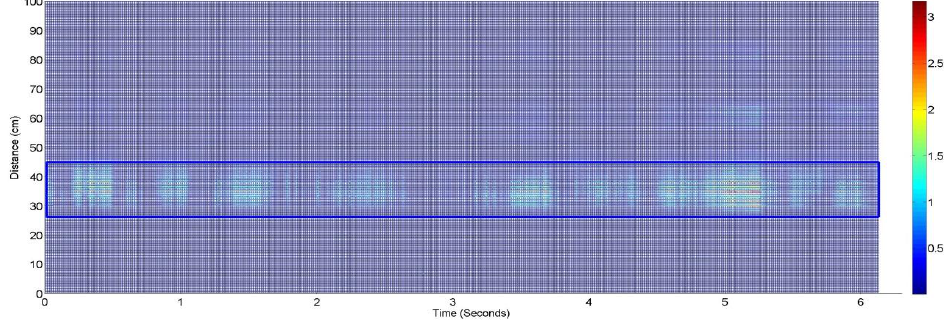
Figure 3. Waveforms after clutter removal where the part highlighted by the rectangle shows the reflection from the human body.